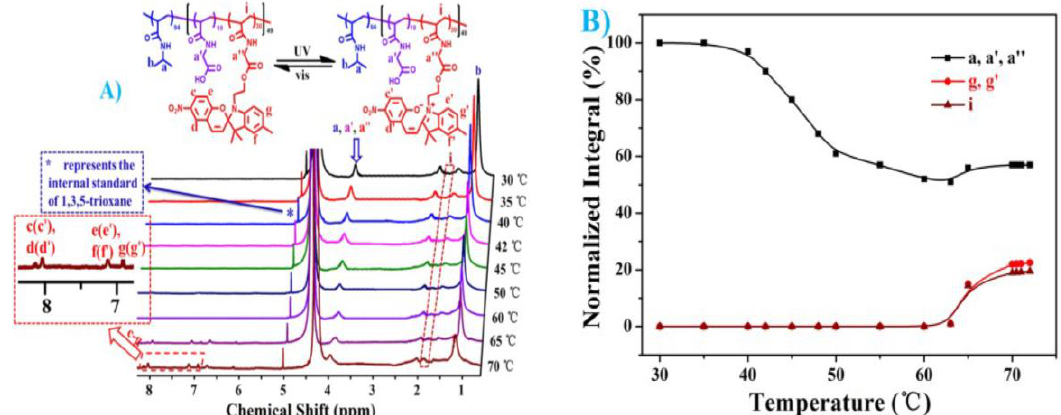
Figure 4 . 1 H NMR spectra of 1 wt % PNIPAAm 94 - b -P(NAG 19 - co -NAGSP 30 ) micelles dispersed in D 2 O at different temperatures ( A ); and the temperature-dependent signals of three typical protons